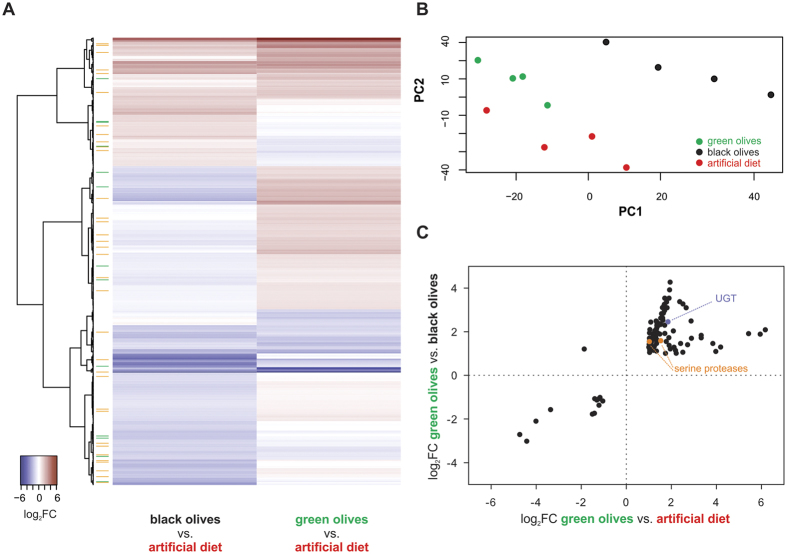
(A) Heatmap plot showing gene expression level ratios (relative to artificial diet) for B. oleae differentially expressed genes (n = 616) in the two olive regimes of this study. Orange and green sidebars indicate genes that code for enzymes predicted to digest food and detoxify plant metabolites, respectively. Clustering of the genes (Euclidean distance, Ward) was based on their relative transcript levels in the two transcriptomic comparisons. (B) PCA plot showing the four biological replicates of each feeding regime: black and green olives and artificial diet. PC1 and PC2 represent 30.00% and 20.04% of the total data variance, respectively. The PCA analysis was performed on the transcript levels of 17,797 genes B. oleae showing an FDR-corrected p¬-value < 0.05 in at least one feeding condition. (C) Scatterplot of significantly differentially expressed genes (n = 108) in both larvae feeding on green olives vs. artificial diet and green olives vs. black olives transcriptomic comparisons. Contig04001 is predicted to code for a UDP-glycosyltransferase (UGT) (indicated in blue). The contigs 04849 and 01887 are predicted to code for digestive serine proteases (indicated in orange).